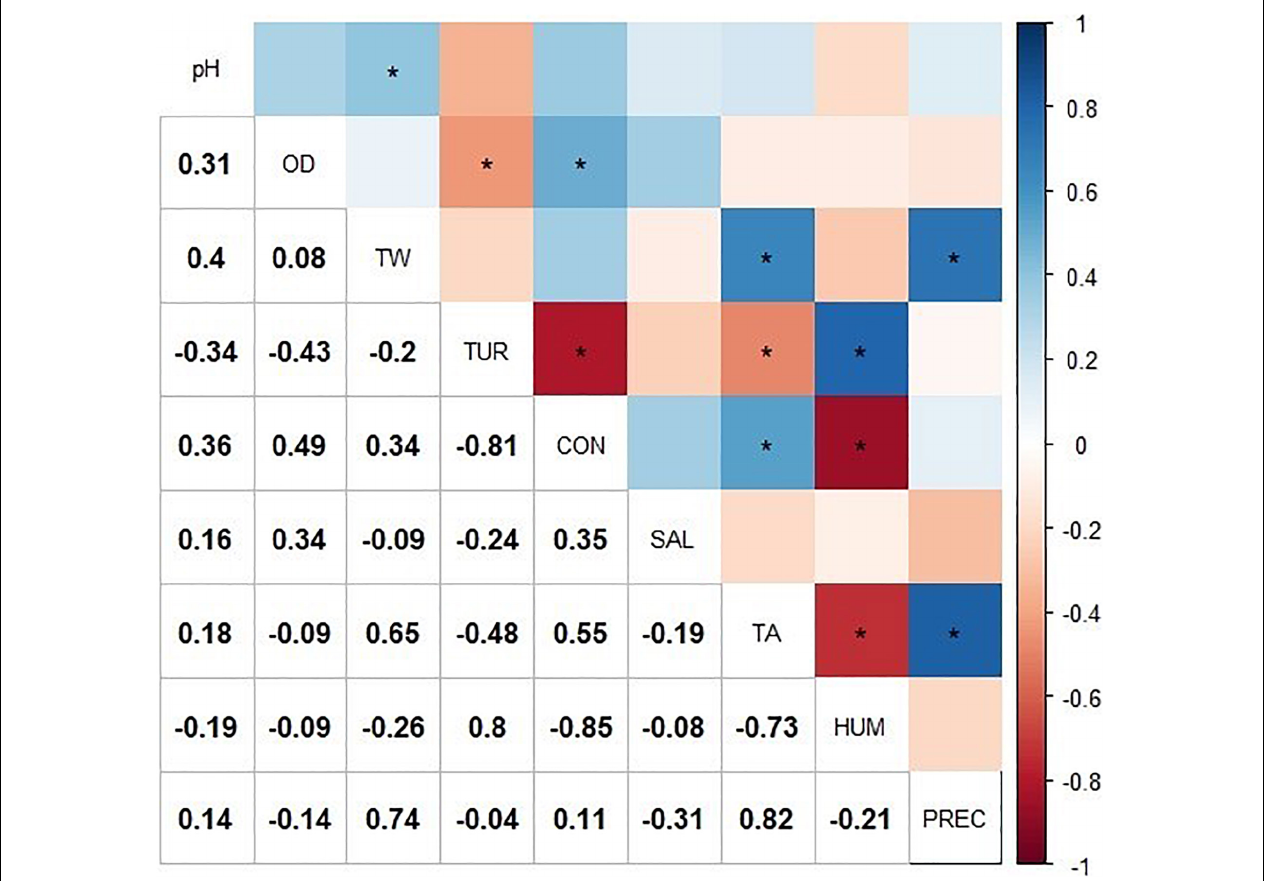
FIGURE 2 | Correlation matrix including the physicochemical and environmental variable values and the presence of Salmonella . The correlogram represents the correlation for all pairs of variables. Positive correlations are displayed in blue and negative correlations in red. The intensity of the color is proportional to the correlation coefficient, so the stronger the correlation (i.e., the closer to − 1 or 1), the darker the boxes. “*” indicates significant Pearson correlation ( p < 0.05). The color legend on the right side of the correlogram shows the correlation coefficients and the corresponding colors. WT, water temperature; DO, dissolved oxygen; CON, electrical conductivity; TUR, turbidity; TA, air temperature; HUM, relative humidity; PREC, rainfall, and SAL, Salmonella